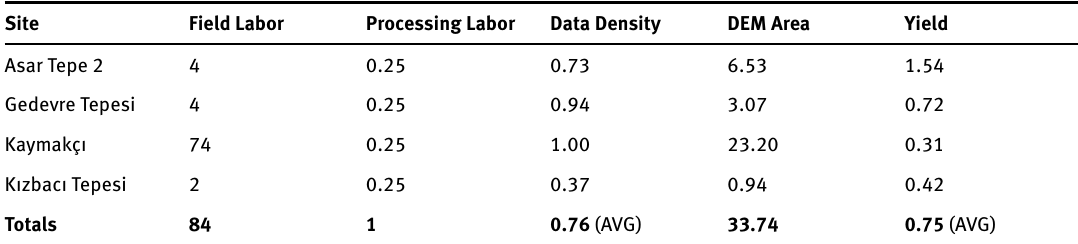
Figure 3: Plan of gridded RTK GNSS survey points at Kaymakçı (left) versus longer traverses at Asar Tepe 2 Table 1: Sites surveyed between 2007 and 2011 using RTK GNSS, showing average field and processing labor (person-days), average data densities (points/m 2 ), areas of valid DEM produced (ha), and yield (ha/person-day).